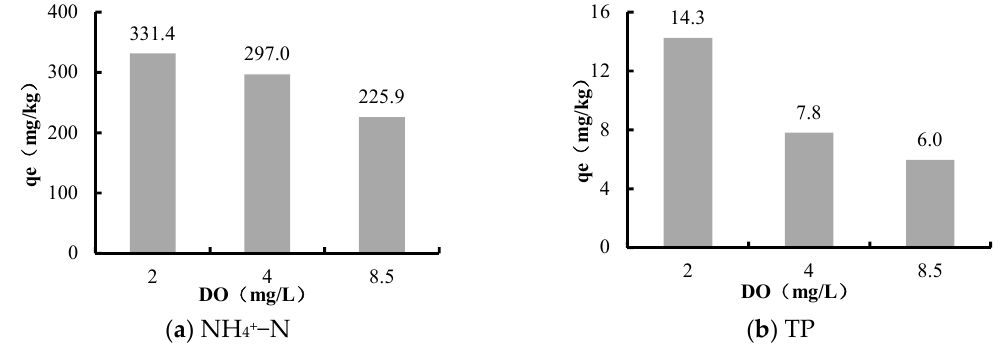
Figure 5. The relation between dissolved oxygen (DO) and the release amounts of NH 4+ –N and TP in Biliuhe reservoir.